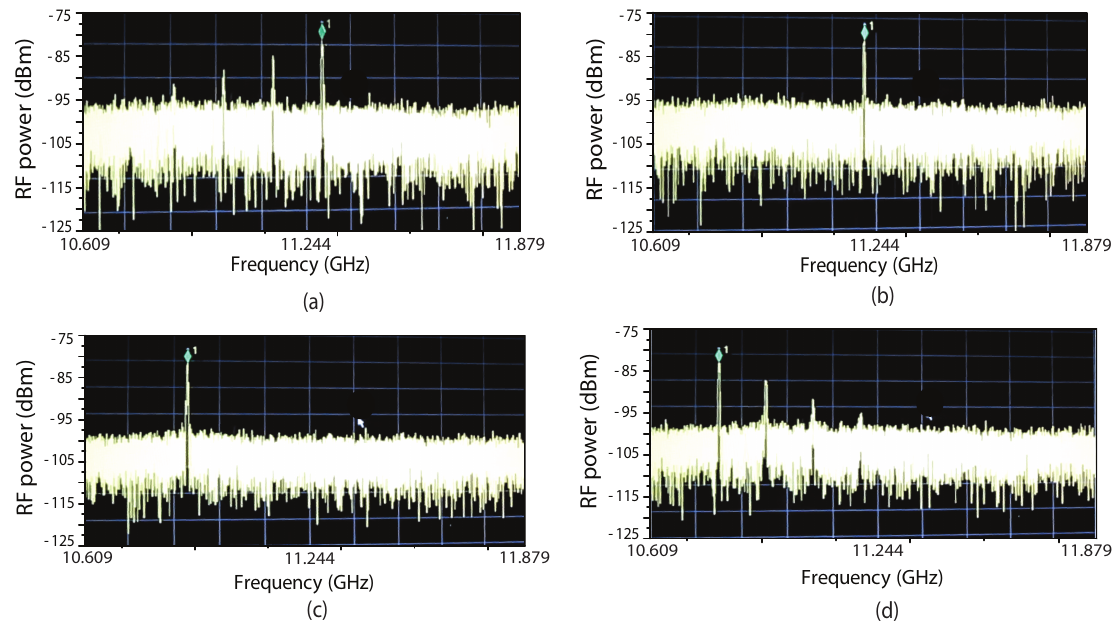
Figure 5. Injection locking range measurement for an injection power of − 18.7 dBm: multiple beat signals indicate no locking ( a , d ); and single beat signal indicated locking occurs ( b , c